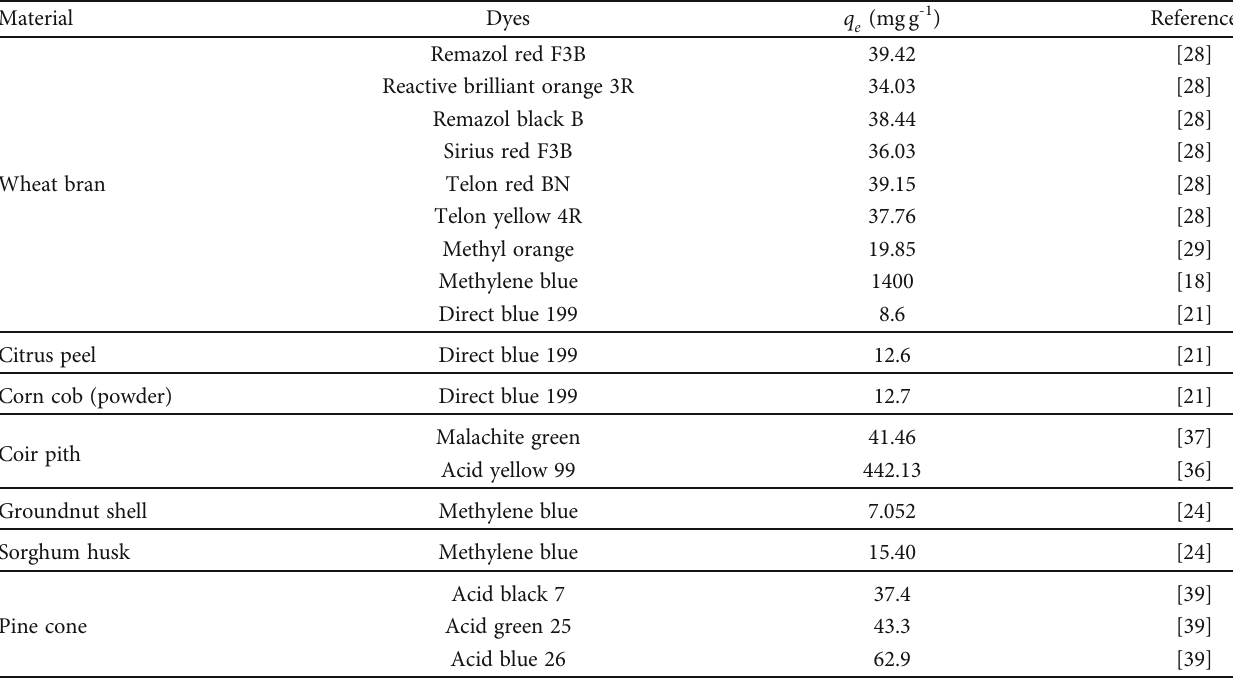
Table 3: Reported adsorption capacities (mgg -1 ) of various biomass-derived adsorbents for the removal of di ff erent dyes.